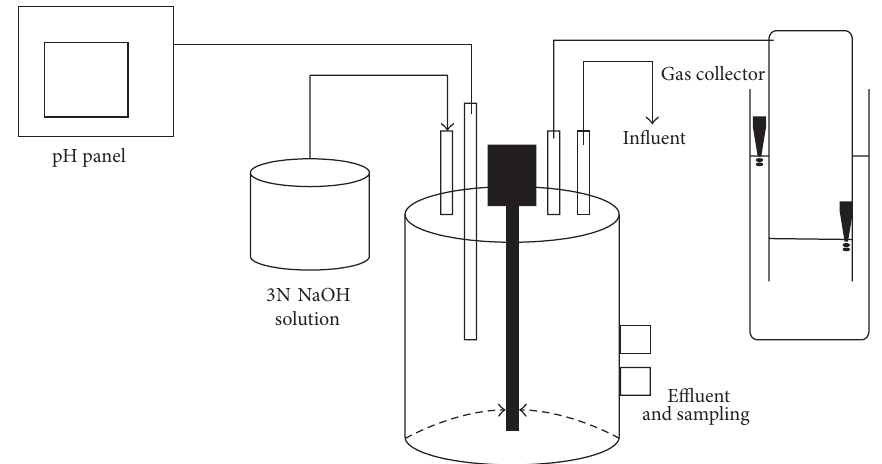
Figure 1: ASBR schematic